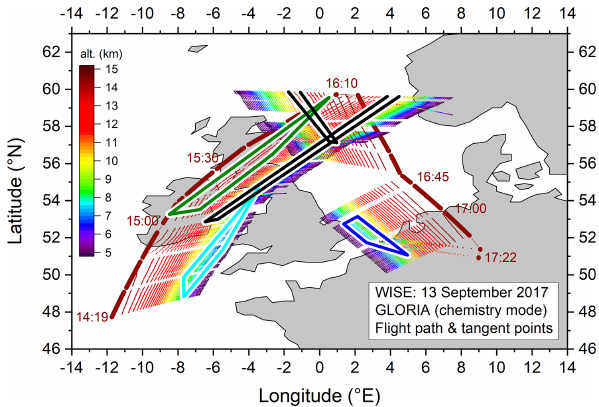
Figure 1. Path of the HALO flight on 13 September 2017 during the WISE campaign (large dark brown points) together with GLORIA tangent points (small points with changing colour according to alti- tude). Measurement times are given in coordinated universal time (UTC). Coloured framed zones mark areas of special interest as discussed in Sect. 3. Note that only observations performed in the chemistry mode are